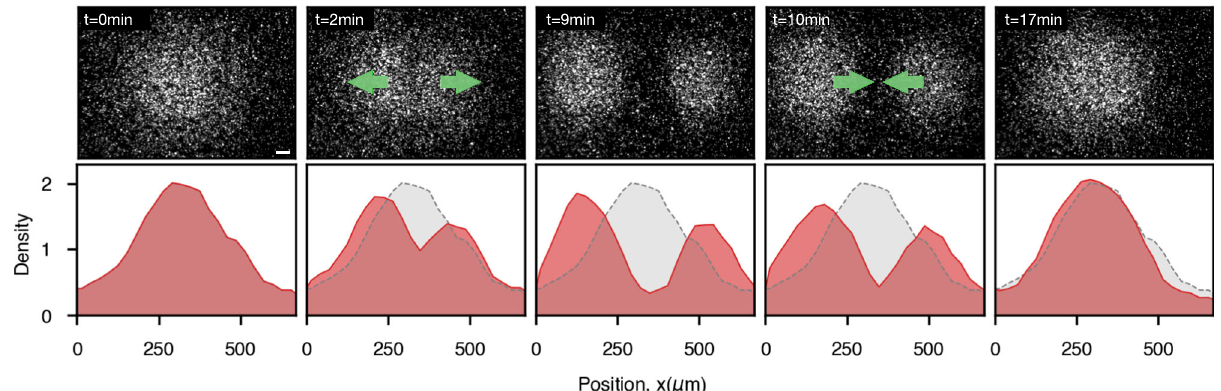
Fig. 5 Splitting and merging of optically con fi ned clouds of motile bacteria. Using a radial transform with two centers we can split an optically con fi ned region of highly motile bacteria into two separate clouds and then merge them together, always conserving the total number of trapped cells. Bottom panel shows the corresponding density pro fi les (red) overlapped to the initial pro fi le at t = 0 (gray). Scale bar is 100 μ m. See Supplementary Movie